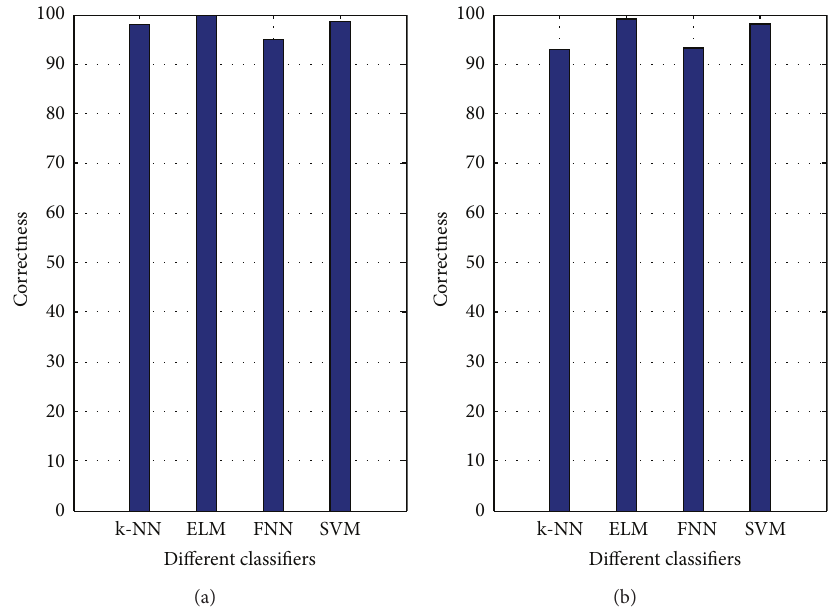
Figure 7: Performance comparison for k-NN, ELM, FNN, and SVM classifiers: AR database: (a) Experiment 1 and (b) Experiment 2.